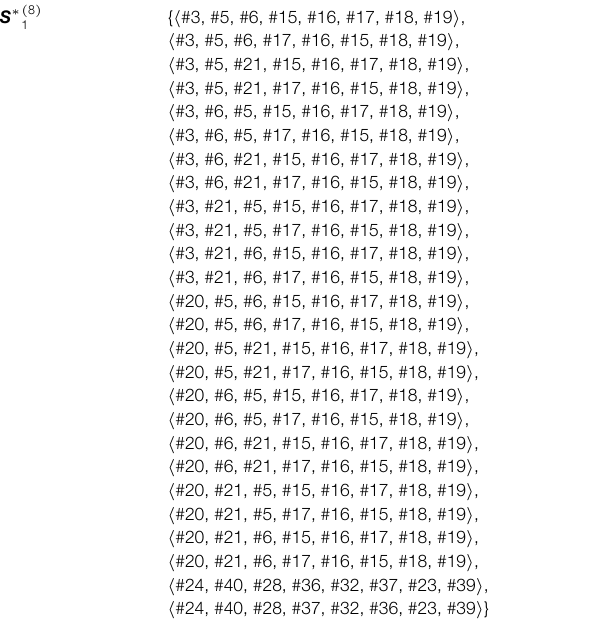
TABLE 1 | Highest-dimensional ES obtained by ESIS for Experiment 1.